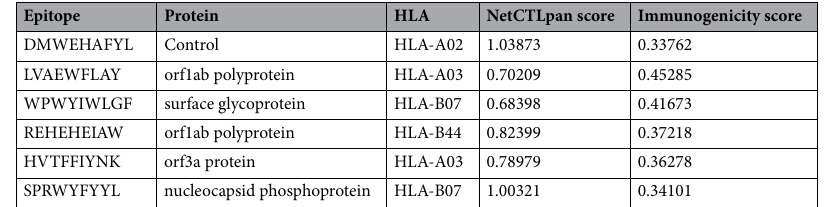
Table 1. The epitope prediction score and immunogenicity score of the top five vaccine epitope